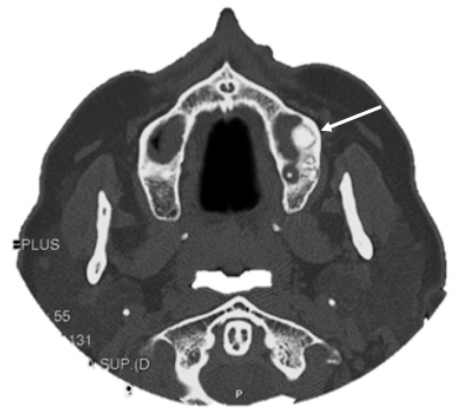
Figure 5. CT scan showing the incidental finding of a small osteoma located in the floor of the left maxillary sinus (white